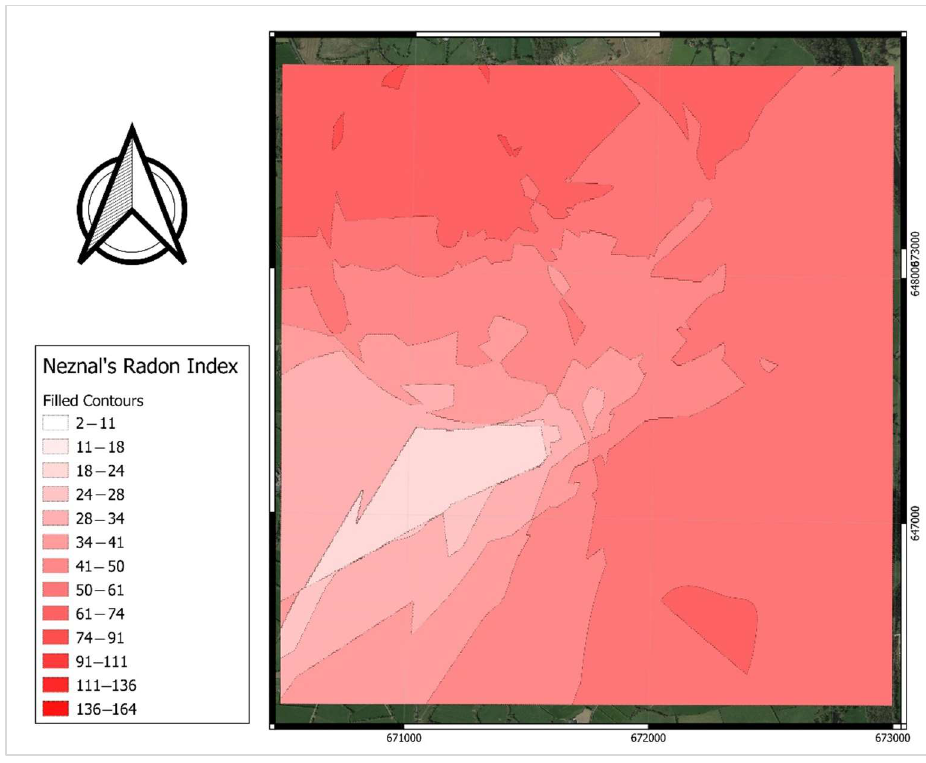
Figure 12. Distribution map of Neznal’s radon index.